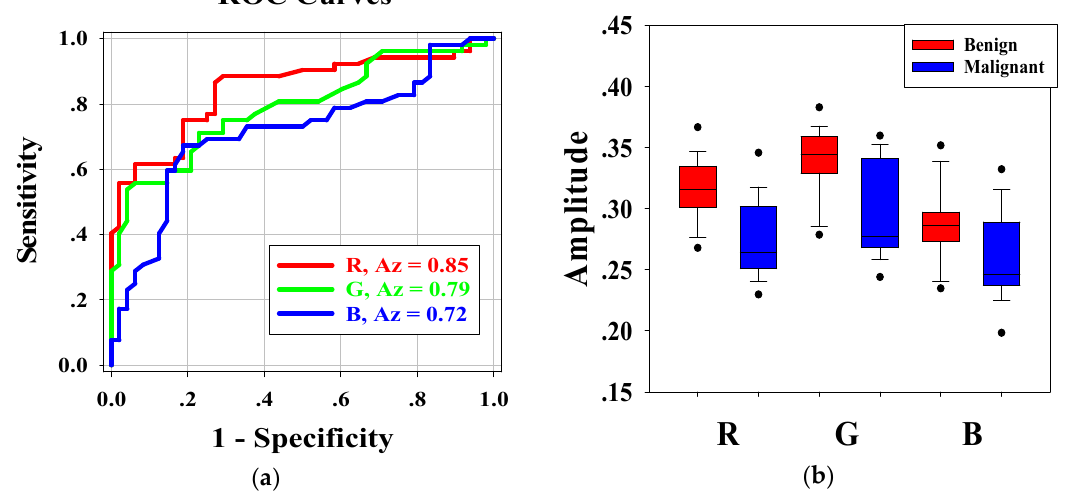
Figure 6. ( a ) The receiver operating characteristic (ROC) curves and the areas under the ROC curves (Az) of the RGB channels. ( b ) Boxplots of the average pixel values of the RGB channels.